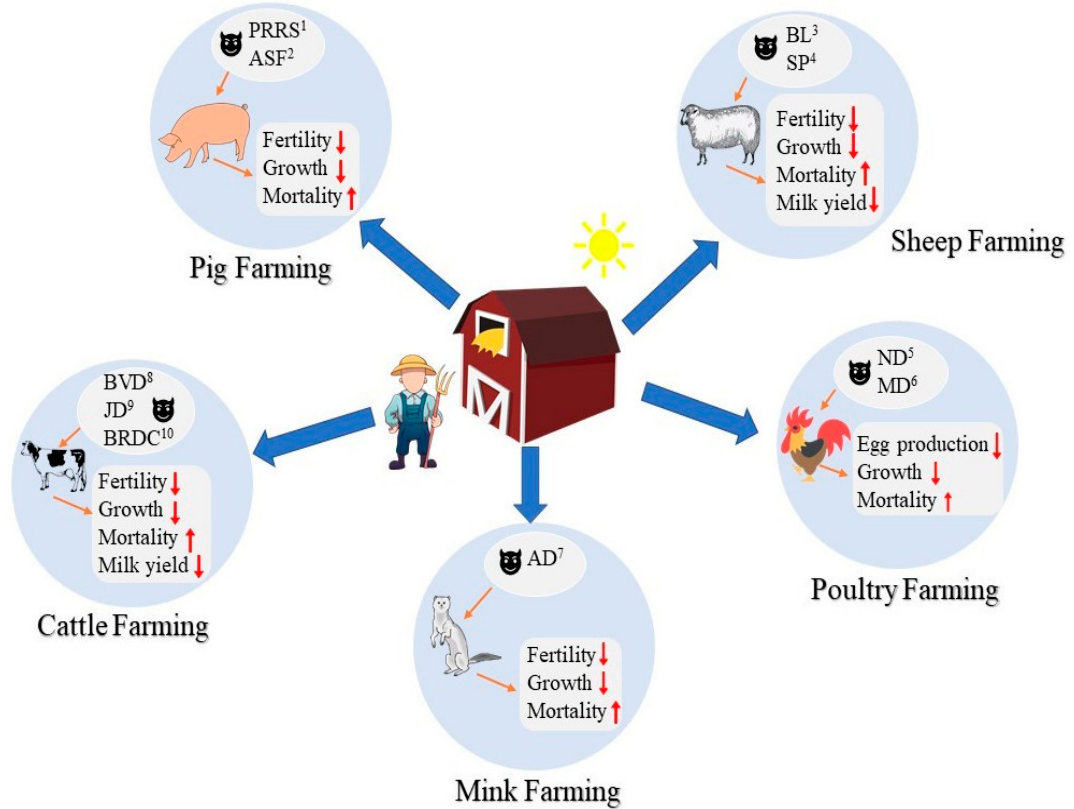
Figure 1. Economic consequences of common diseases in farm animals including pig, sheep, poultry, mink, and cattle. The upward-pointing arrows refer to increase, and the downward-pointing arrows refer to decrease (PRRS 1 = Porcine reproductive and respiratory syndrome; ASF 2 = African swine fever; BL 3 = Bluetongue; SP 4 = Sheep pox; ND 5 = Newcastle disease; MD 6 = Marek’s disease; AD 7 = Aleutian disease; BVD 8 = Bovine viral diarrhea; JD 9 = Johne’s disease; BRDC 10 = Bovine respiratory disease complex).